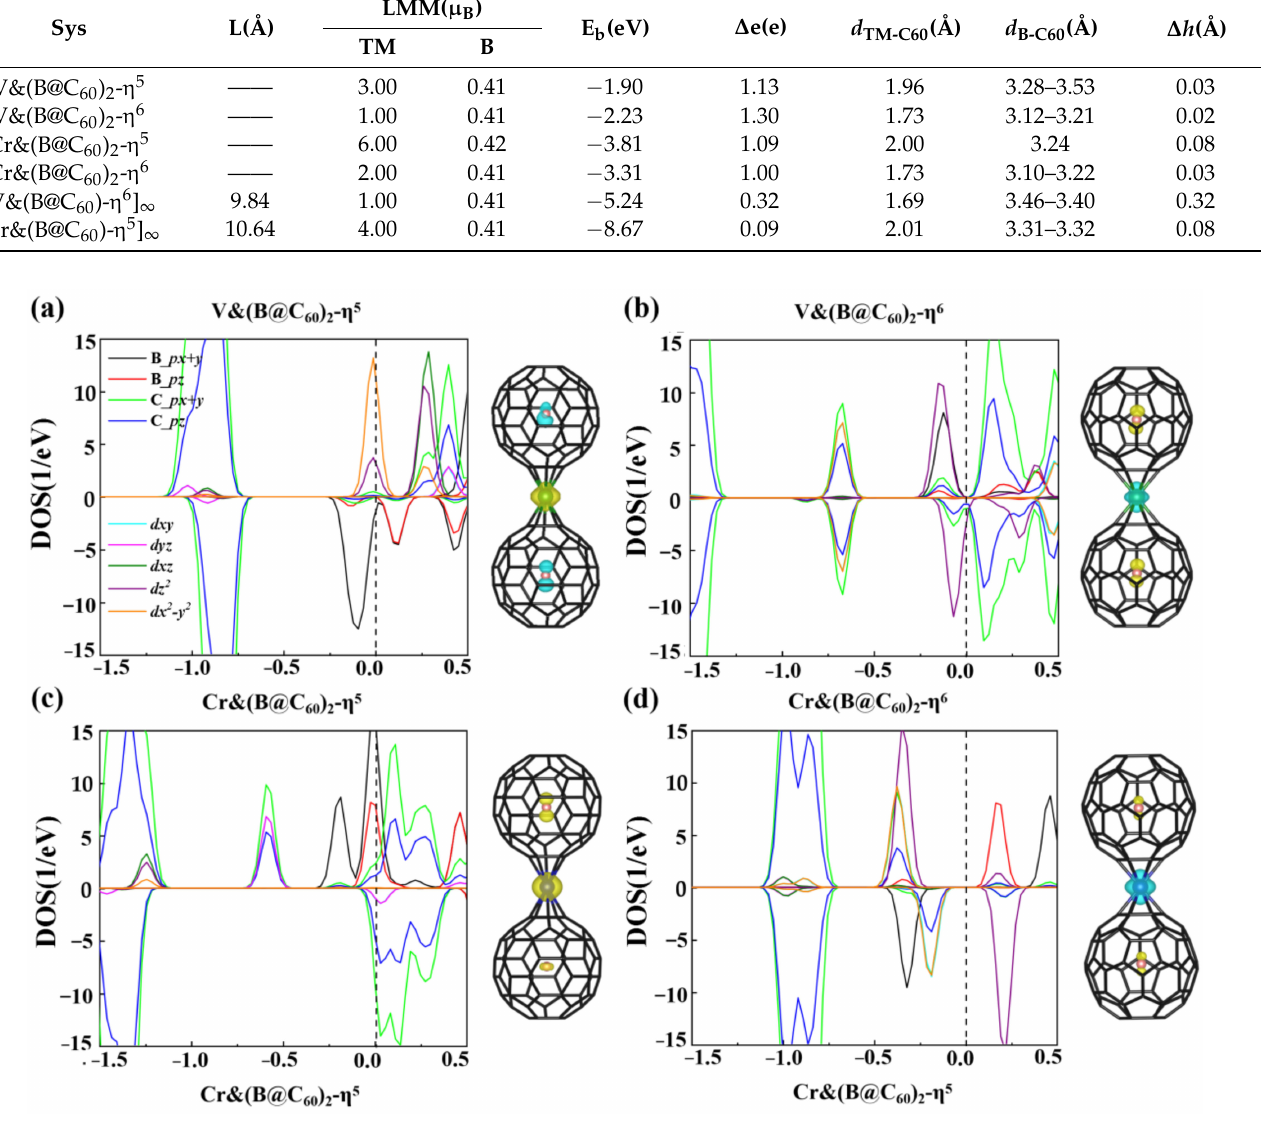
Figure 2. The spin density and PDOS of V&(B@C 60 ) 2 ( a , b ) and Cr&(B@C 60 ) 2 ( c , d ). To determine the magnetic ground states of these TM&(B@C 60 ) 2 clusters, we consid- ered different spin states for each system (see Table S1 in the supporting information, SI). For V&(B@C 60 ) 2 , the magnetic moment of its ground state is 3.0 µ B and 1.0 µ B in their η 5 / η 6 coordinated configurations. Their second lower-energy isomers are found to have magnetic moments of 5.0 µ B and 3.0 µ B, which are less stable than the ground states by approximately 0.01 eV and are 0.03 eV higher in energy, respectively. In addition, for Cr&(B@C 60 ) 2 - η 5 and Cr&(B@C 6 0) 2 - η 6 , the magnetic moment of 6.0 µ B and 2.0 µ B is observed for their ground states, which are approximately 0.03 eV and 0.17 eV lower in energy, respectively, than their second higher-energy isomers with the same magnetic moment of 4.0 µ B. The inset in Figure 2 shows the spin densities of V&(B@C 60 ) 2 and Cr&(B@C 60 ) 2 . Clearly, the